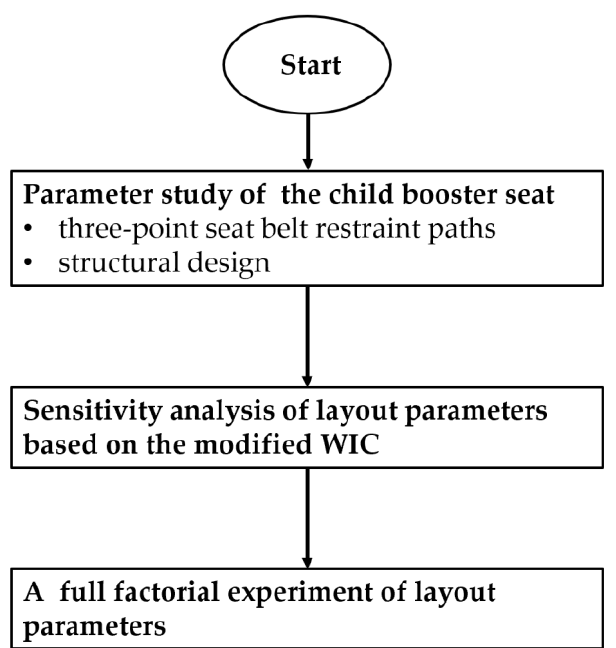
Figure 5. The design framework of sensitivity analysis-based full factorial experiment.